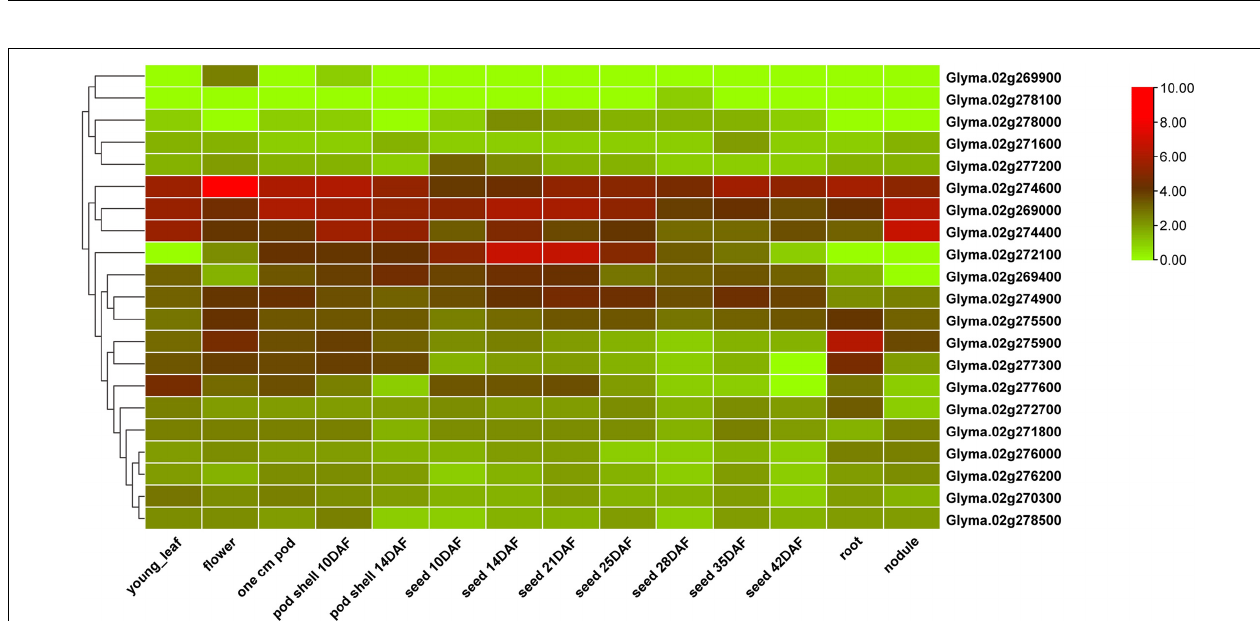
FIGURE 5 | Heatmap visualization of relative gene expression in different tissues and developmental stages, for the candidate genes predicted in the qSS2 physical interval. Normalized FPKM values are depicted on the log2 scale.